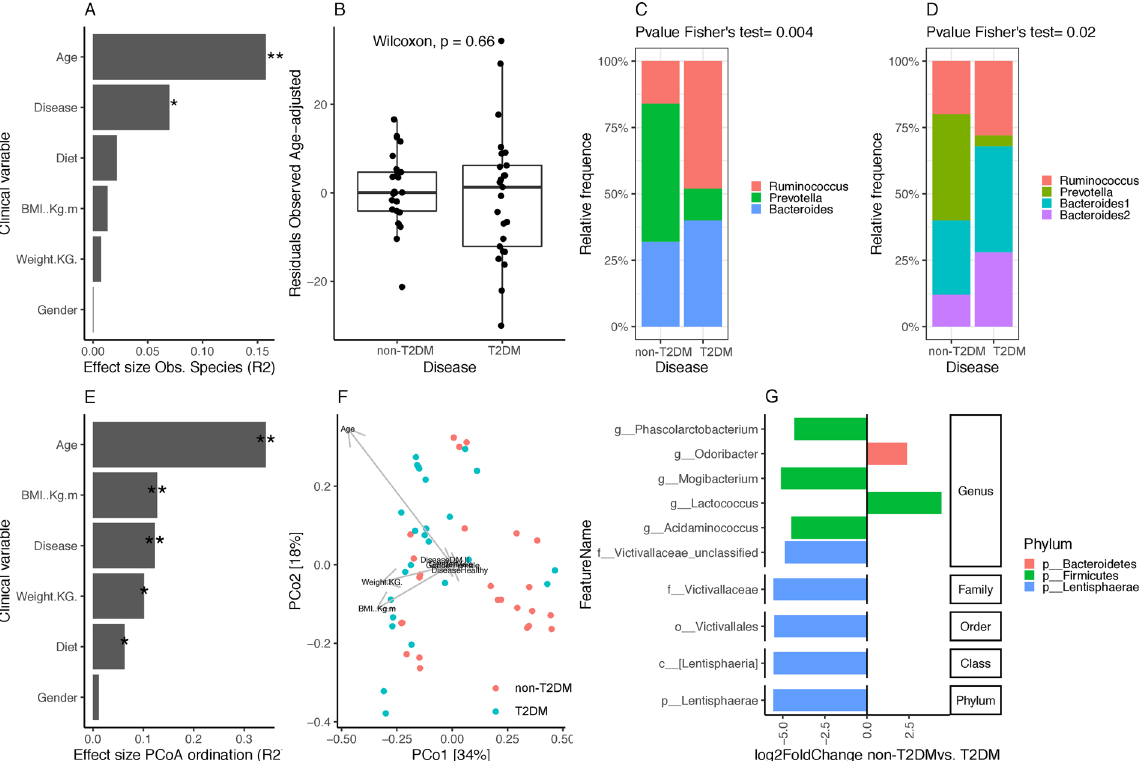
Figure 1. Prokaryotic profiling of gut microbiome. ( A ) Effect sizes of clinical covariates and disease state over Alpha diversity distribution (observed species) based on linear regression analyses ( ** = FDR < 0.05; * = P value < 0.05, FDR > 0.05) ( B ) Differences in residuals of linear-regression between alpha diversity (Observed species, dependent variable) and age (independent variable) between study groups. ( C ) Enterotype composition in non-T2DM and T2DM individuals by PAM clustering over JSD distance matrix computed from genus abundance data. ( D ) Enterotype composition in non-T2DM and T2DM individuals by DMM approach from genus abundance data. ( E ) Effect sizes of environmental fitting of clinical variables and disease state over PCoA ordination ( ** = P value < 0.05; * = P value < 0.1; permutation test) ( F ) Principal coordinates analyses of inter-individual differences (genus-level Bray-Curtis beta-diversity) with samples colored by disease state (non- T2DM, T2DM). Arrows represents effect sizes of the significant variables identified by environmental fitting analyses of panel E. ( G ) Barplot of log2 fold changes in taxonomic feature abundances between health controls and T2DM (P value < 0.05 in GLM model with negative binomial distribution of feature abundance by disease state adjusted by